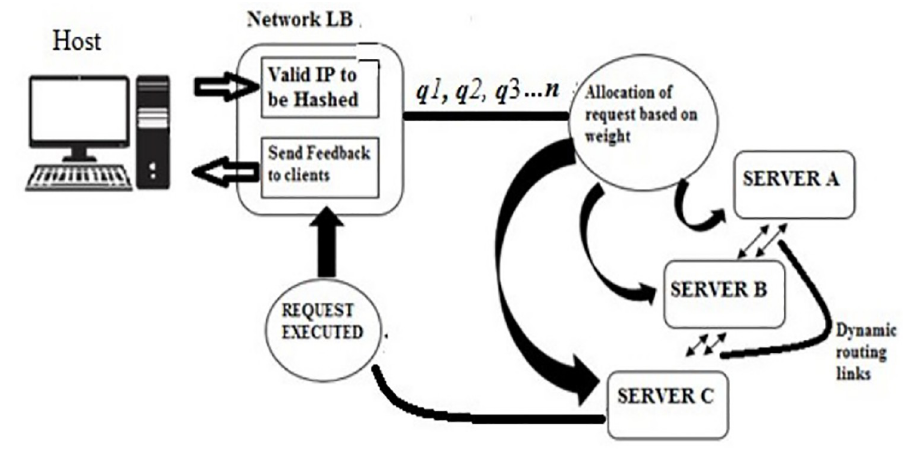
Fig 3. Architectural module of HDW.